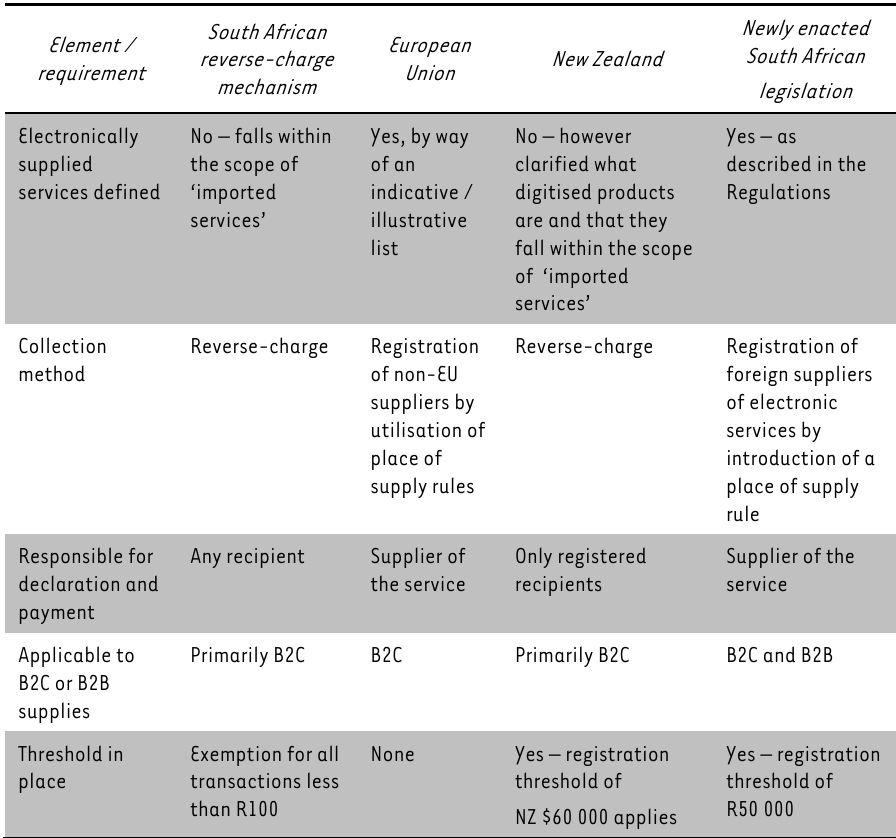
TABLE 1: Summary of difference in legislation Element